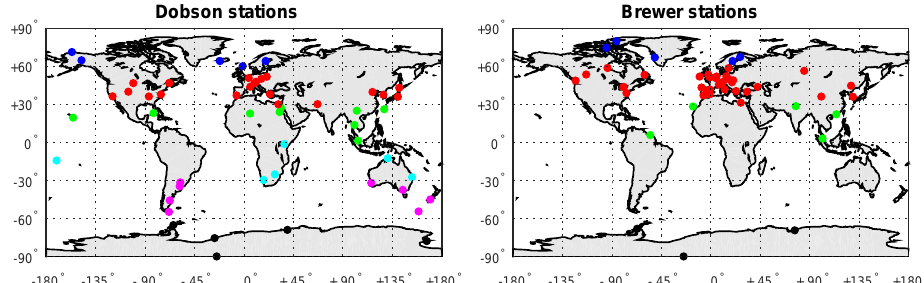
Figure 9. Location of the WOUDC network of ground-based stations used in the present validation exercise; Dobson stations are shown on the left and Brewer stations on the right. The colors indicate different latitude bands: 60–90 ◦ N (blue), 30–60 ◦ N (red), 0–30 ◦ N (green), 0–30 ◦ S (cyan), 30–60 ◦ S (magenta), and 60–90 ◦ S (black).